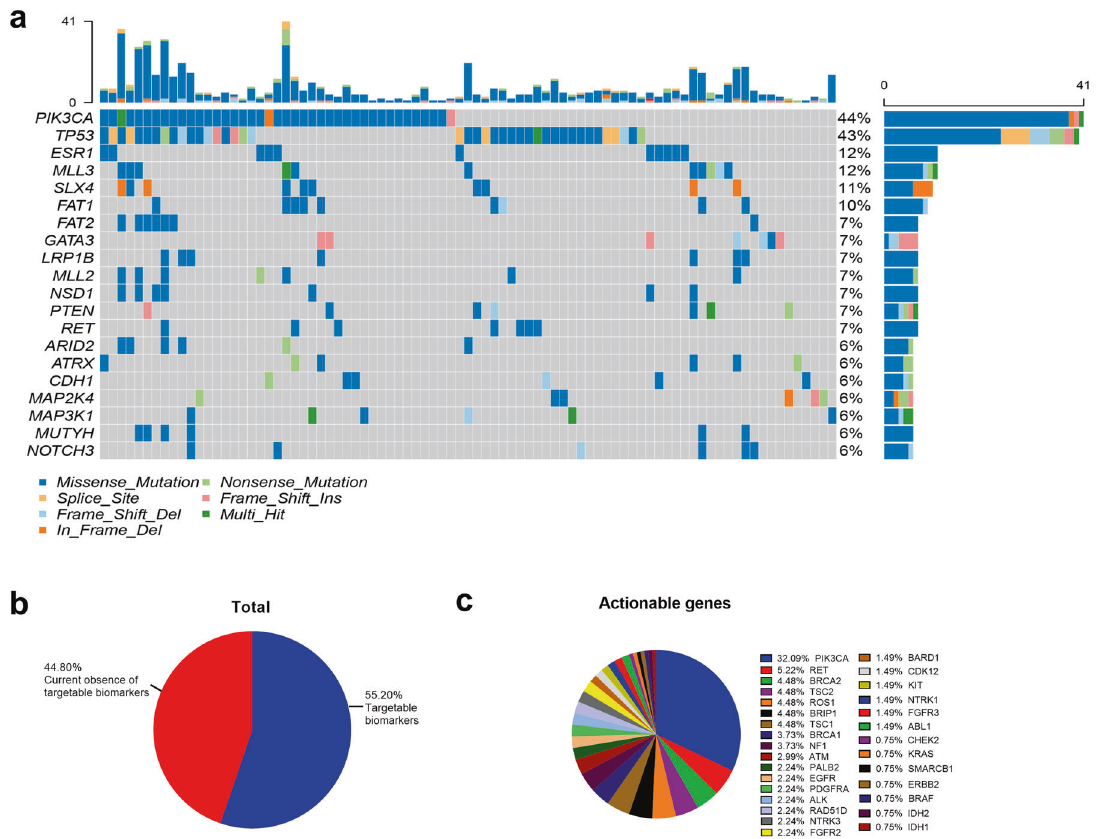
Fig. 1 Mutational characteristics. a Mutational spectrum of the top 20 genes at pretreatment from 117 patients. b Percentage of patients with and without actionable targets for treatment. c Genes indicated by the OncoKB knowledge base for which targeted drugs are Food and Drug Administration